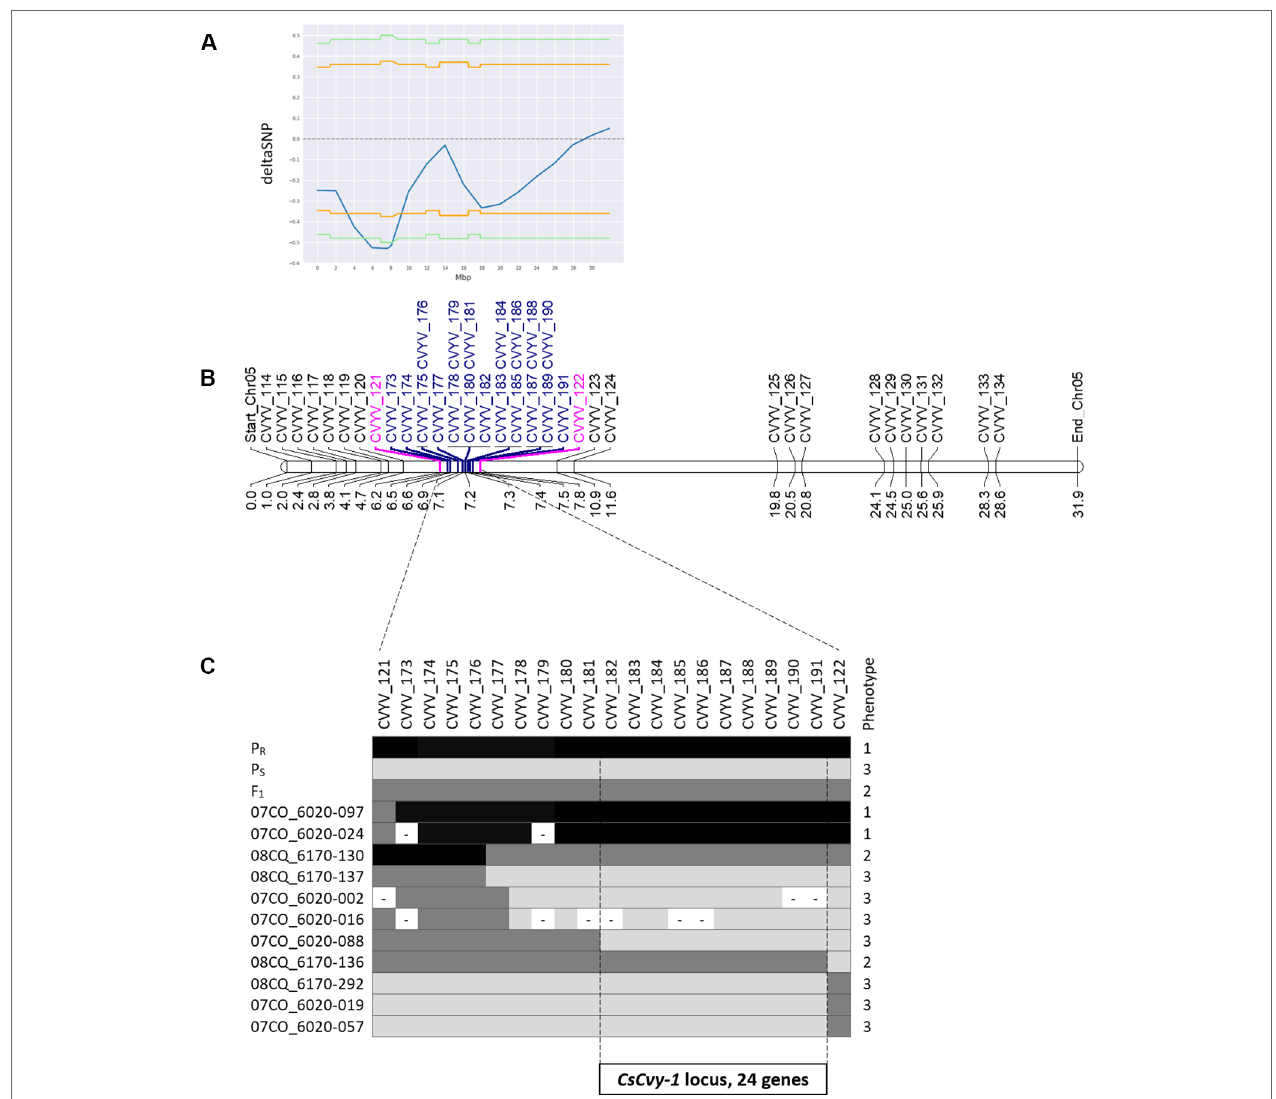
FIgURe 4 | Scheme of fine mapping of the CsCvy-1 locus. (A) DeltaSNP graph on Chr05 with the statistical confidence interval of 0.95 (orange line) or 0.99 (green line) (B) Physical map of Chr05 with all the markers used for mapping the CsCvy-1 locus: preliminary mapping (black), flanking markers (magenta), fine mapping markers (blue). Distance is expressed in Mb on the bottom of the bar. (C) Genotyping result of recombinant individuals with the markers covering CsCvy-1 locus. Alleles are represented in three colors: black for homozygous P R allele, dark grey for heterozygous P R /P S , and light grey for homozygous P S allele.